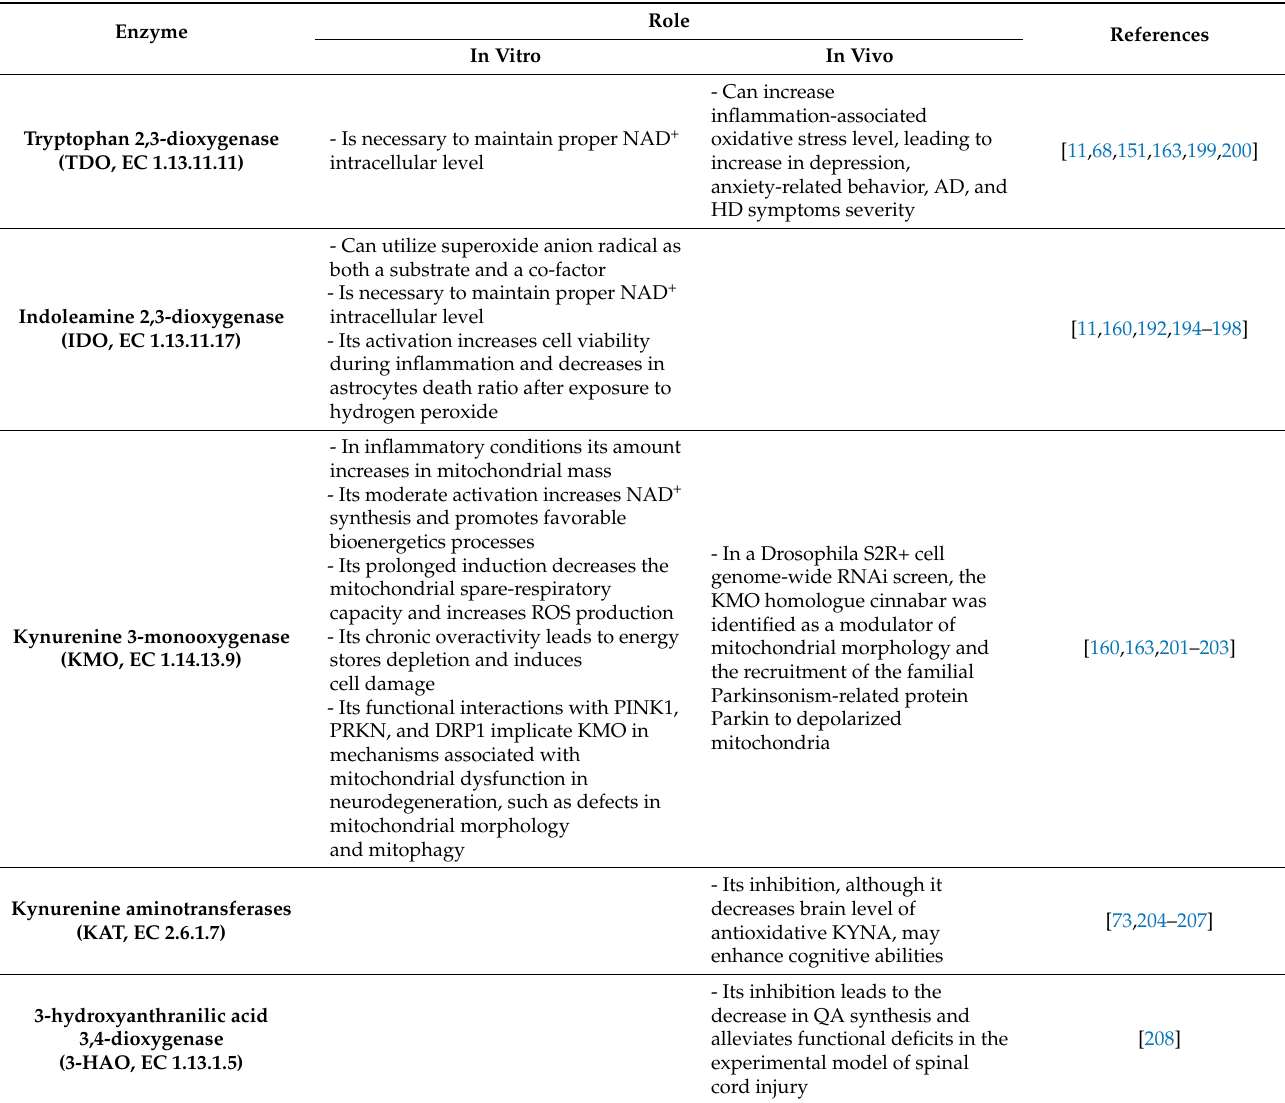
Table 2. Impact of enzymes of the kynurenine pathway on oxidative stress during the development of neurodegenera- tive processes. Enzyme